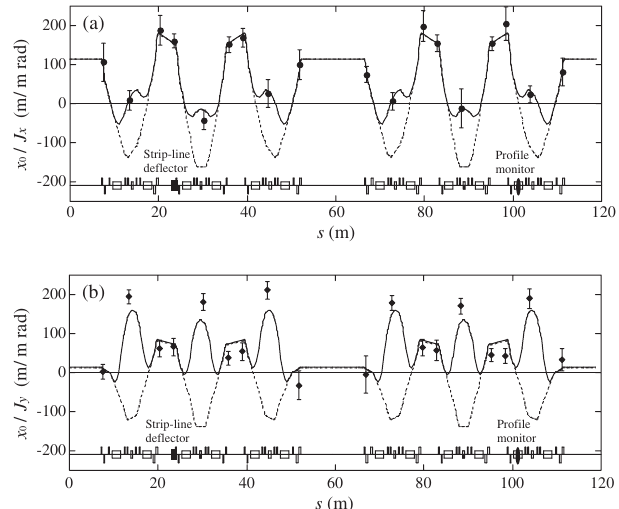
FIG. 4. Amplitude dependent orbit shift by (a) the horizontal betatron oscillation and (b) the vertical betatron oscillation. The circles and the diamonds are the measured shift at the BPMs. The error bars are measurement errors estimated from the variation of 20 measurement results. The broken lines and the solid lines are the calculated shift using the analytical formulas, Eqs. (9) and (12), respectively. The shaded square and the shaded ellipse show the locations of the strip-line deflector and the synchrotron radiation profile monitor,